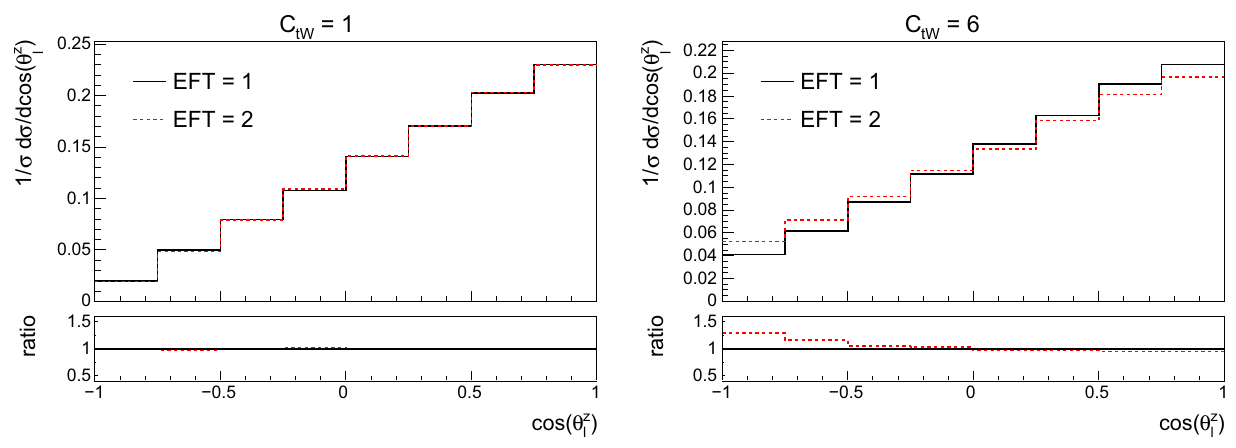
Fig. 10 The top polarisation angle at LO with different values for the O tW effective operator. On the left hand side results for C tW = 1 are shown, whilst C tW = 6 on the right hand side. The comparison between one and two EFT insertions is